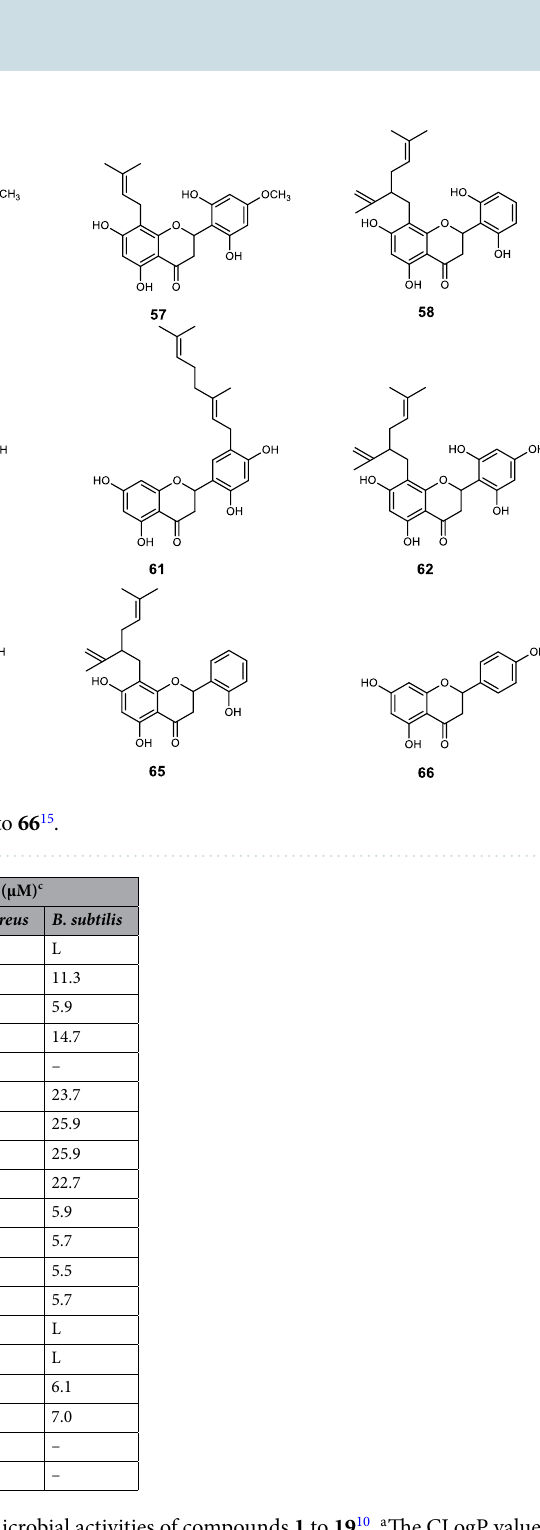
Table 1. Physico-chemical parameters and antimicrobial activities of compounds 1 to 19 10 . a The CLogP values were calculated using software ChemBioDraw Ultra 12.0. b The ACD/Log P and LogD 7.40 values were calculated using software ACD/Labs 6.0. c MIC, minimum inhibitory concentration; S. aureus , Staphylococcus aureus ; B. subtilis , Bacillus subtilis ; L, lower activity than other compounds while no data was given; –, no data was